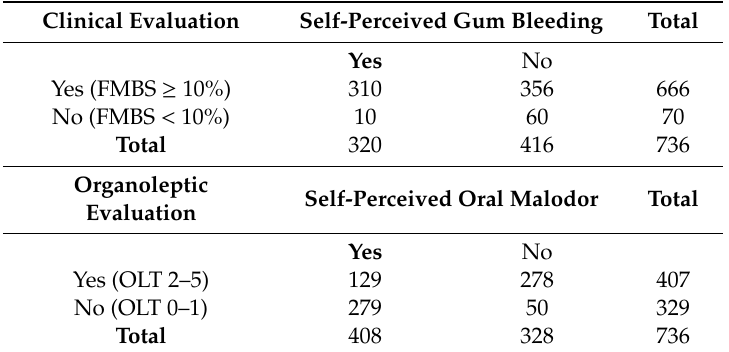
Table 1. Agreement between self-perceived and clinically diagnosed gingival bleeding and oral malodor. FMBS, full-mouth bleeding score; OLT, organoleptic